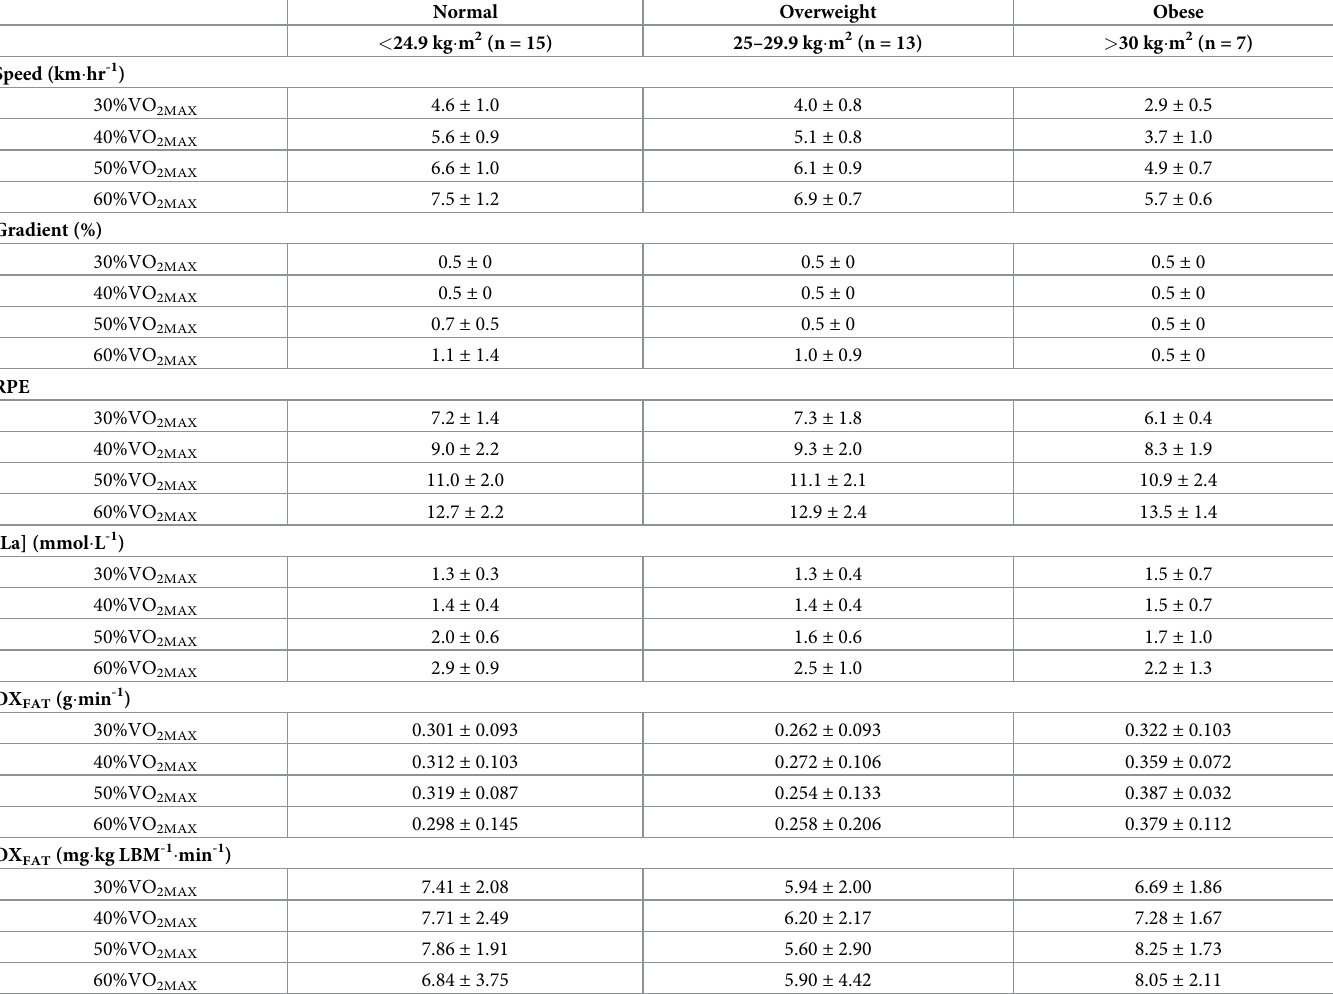
Table 2. Physiological responses during the submaximal graded test. Speed, gradient, ratings of perceived exertion, blood lactate concentration and absolute and rela- tive substrate oxidation of participants classified according to BMI groups.